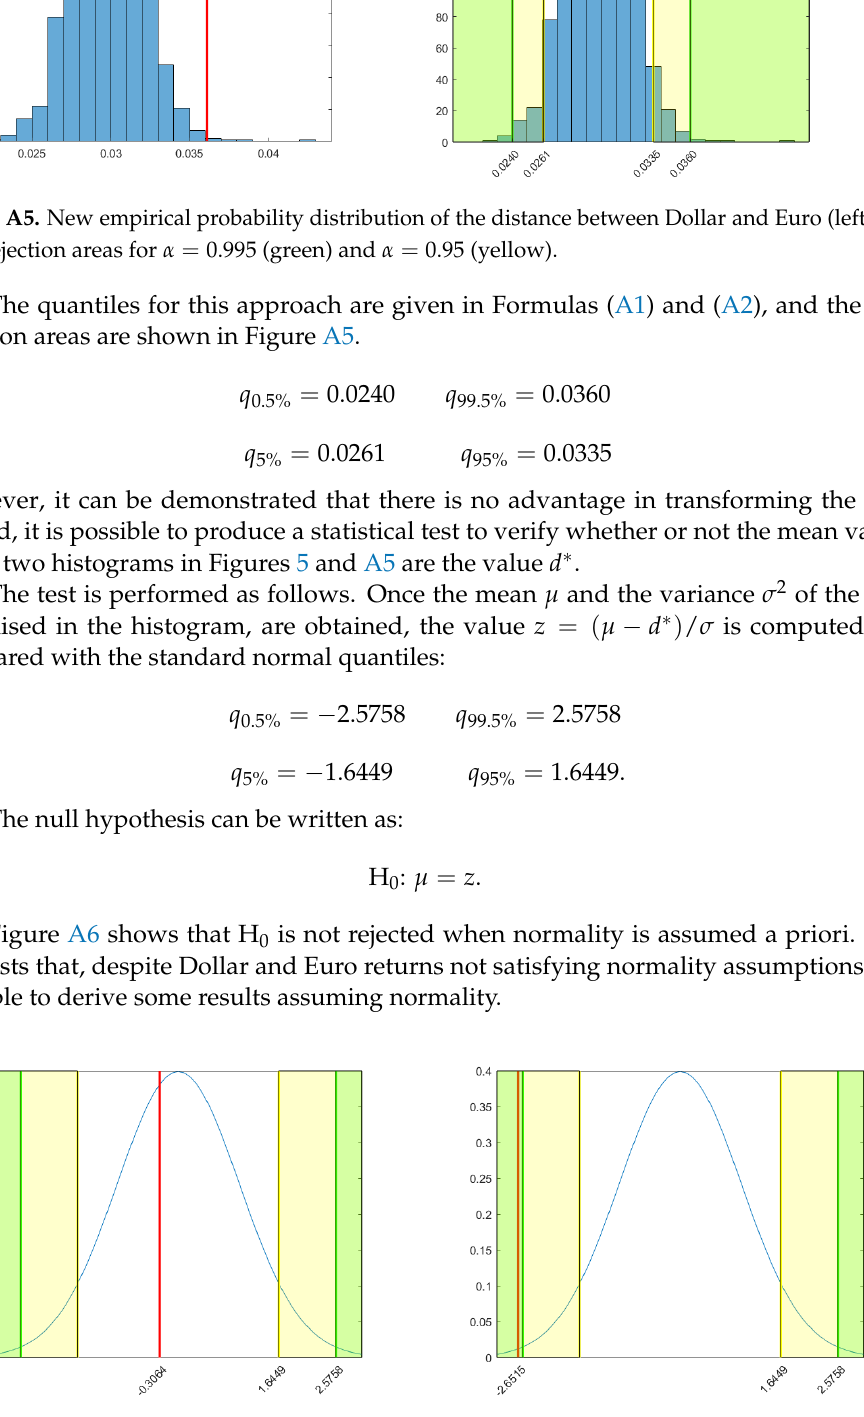
Figure A6. Quantiles of the standard normal distribution and the value z (in red). On the ( left ), the case in which normality is assumed a priori. On the ( right ), the case in which data are